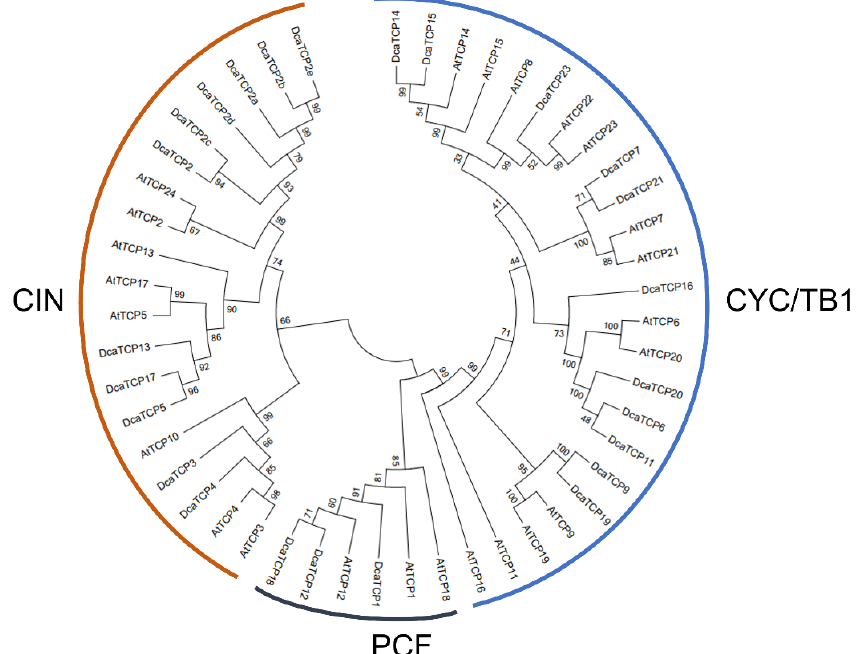
Figure 1. Phylogenetic tree of TCP proteins from D. catenatum and Arabidopsis . The phylogenetic tree was generated using the neighbor-joining (NJ) method implemented in the MEGA 7.0 software with JTT model and the pairwise gap deletion option. Bootstrap analysis was conducted with 1000 iterations.